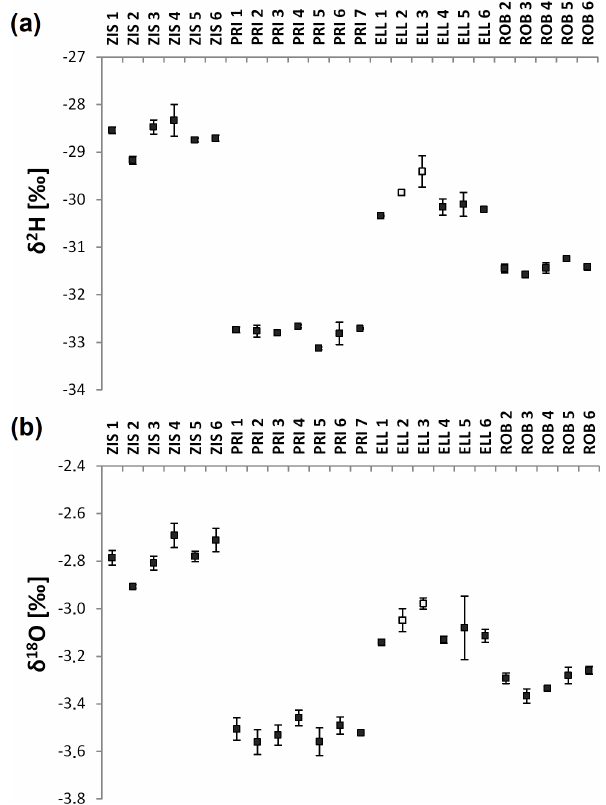
Figure 6. (a) δ 2 H and (b) δ 18 O values from samples taken at Zierker See (ZIS), Großer Priepertsee (PRI), Ellbogensee (ELL), and Röblinsee (ROB). For locations of samples refer to Table 3 and Fig. 2. White squares mark samples before the confluence with the upper Havel at